Question: What style of plot is this figure drawn as?
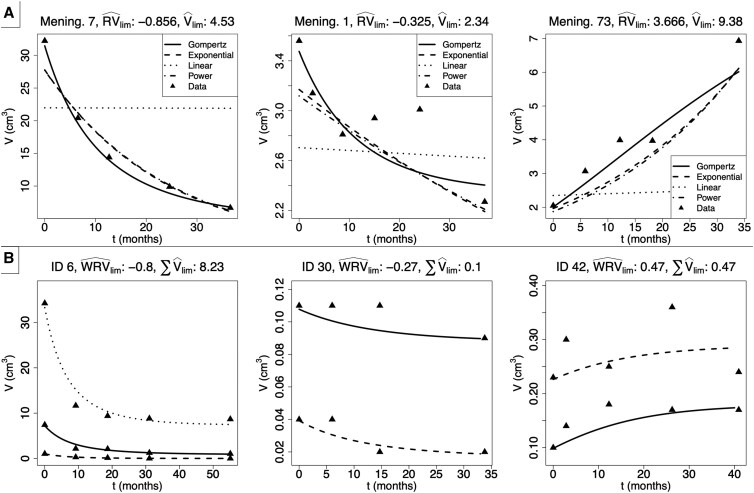
Answer: line